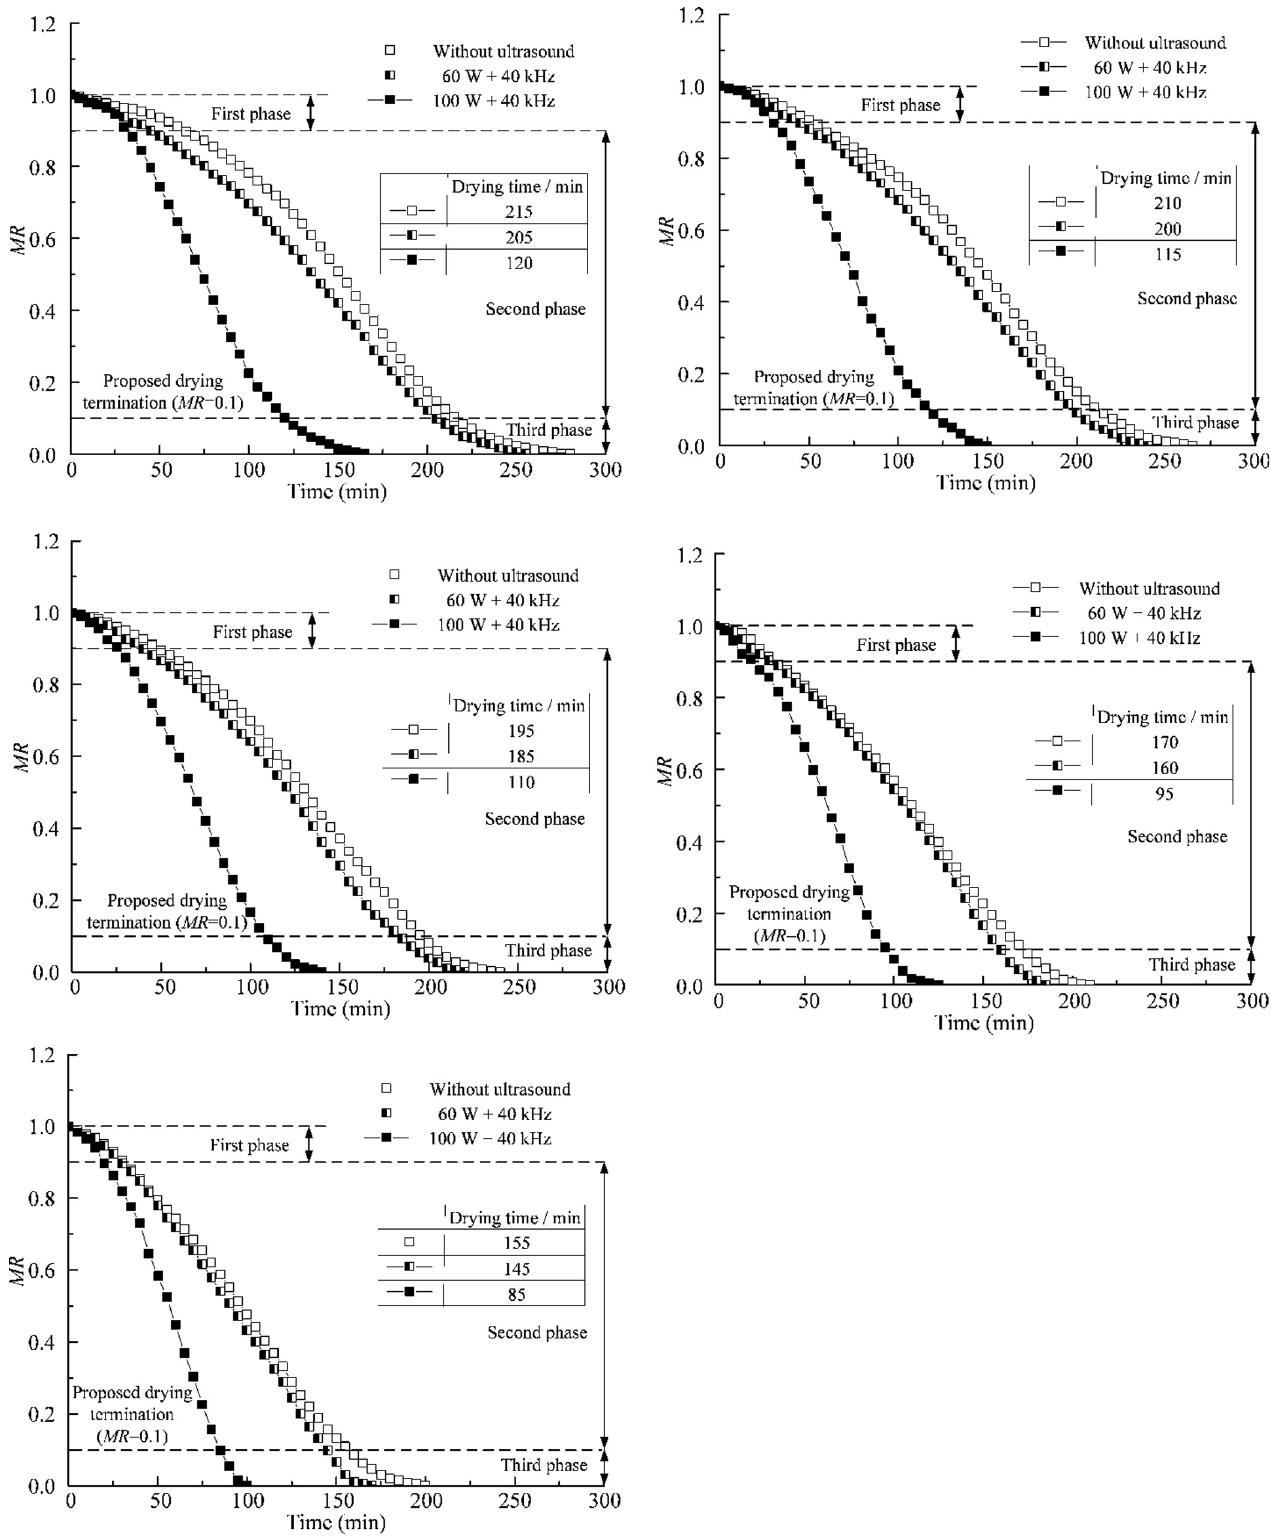
Fig 6. Influence of ultrasound power on thermal drying at different temperatures. (a) 60˚C (b) 70˚C (c) 80˚C (d) 90˚C (e) 100˚C.